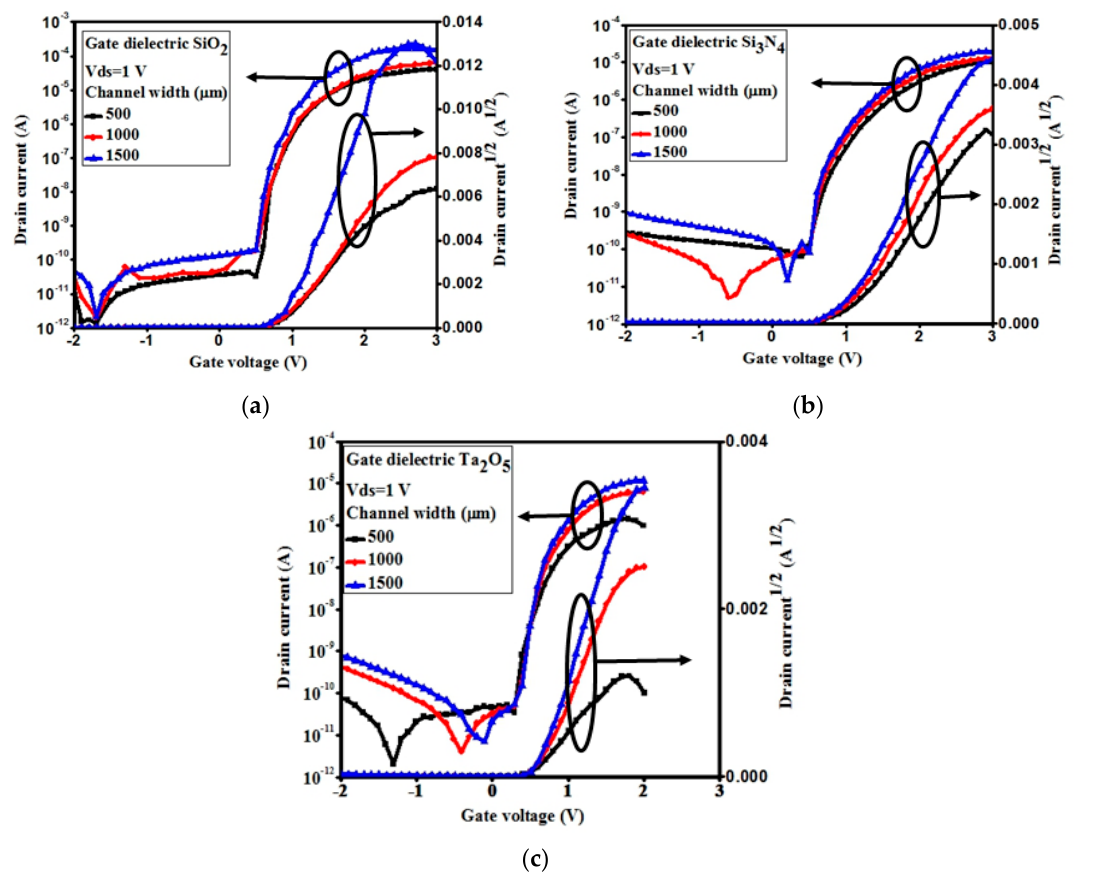
Figure 6. Typical transfer characteristics of the a ‐ IGZO ‐ based thin ‐ film transistors (TFTs) with gate dielectric ( a ) SiO 2 , ( b ) Si 3 N 4 , and ( c ) Ta 2 O 5 at different channel widths of 500, 1000, and 1500 μ m. The drain voltage was 1 V, and the right ‐ hand side graph shows the characteristics of I d1/2 vs. voltage to determine the threshold voltages.